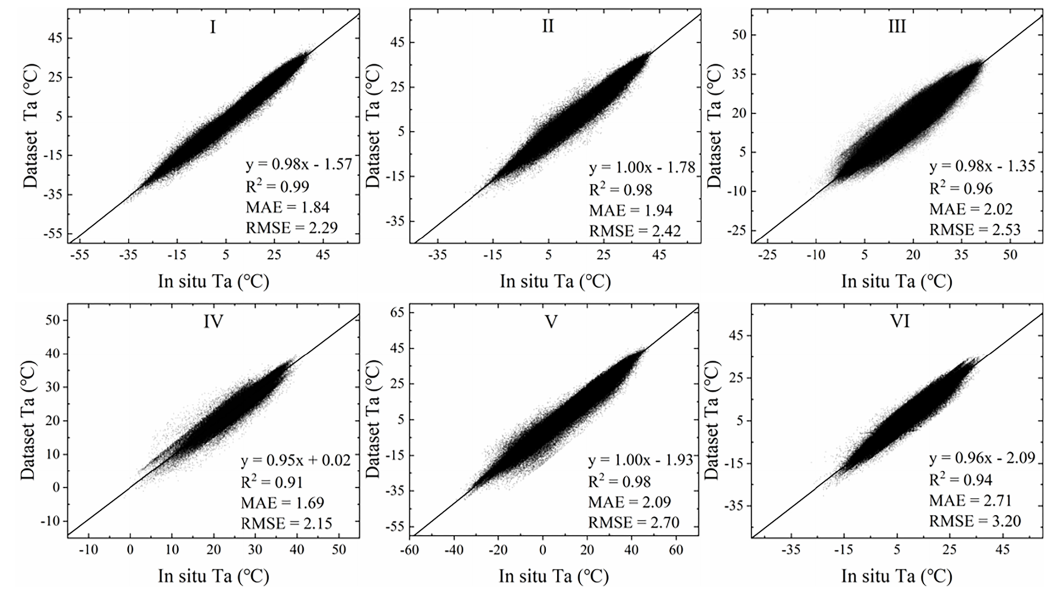
Figure 6. Scatter diagrams of the T max output from the T a model against ground station data; statistical accuracy measures ( R 2 , MAE, and RMSE) are also indicated.